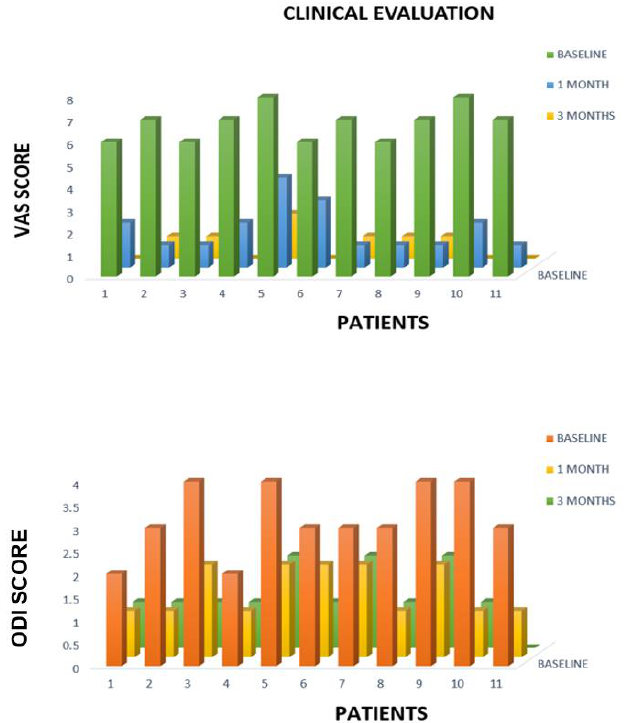
Figure 4. Comparison of VAS and ODI score at baseline, 1 month and 3 months after the proce-